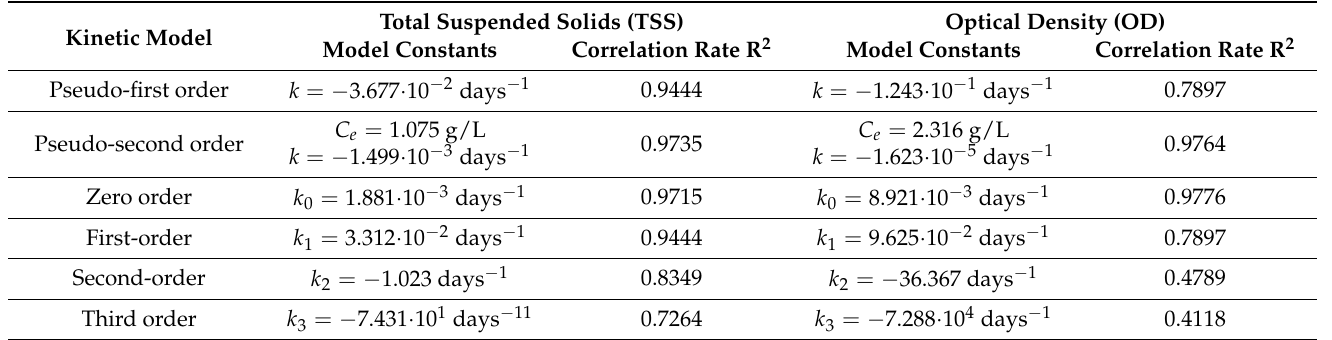
Table 2. Kinetic constants and correlation rates for each evaluated kinetic model.